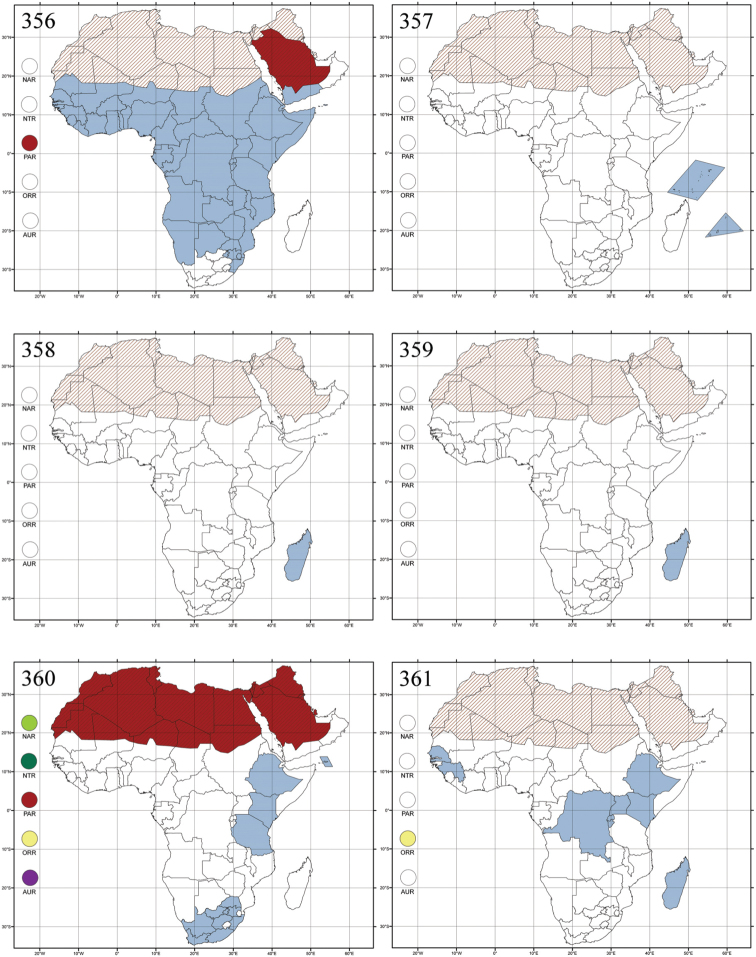
Maps of distribution. 356
Polyclada Chevrolat 357
Pratima Maulik 358
Pseudadorium Fairmaire 359
Pseudophygasia Biondi & D’Alessandro, in press 360
Psylliodes Berthold 361
Sanckia Duvivier.